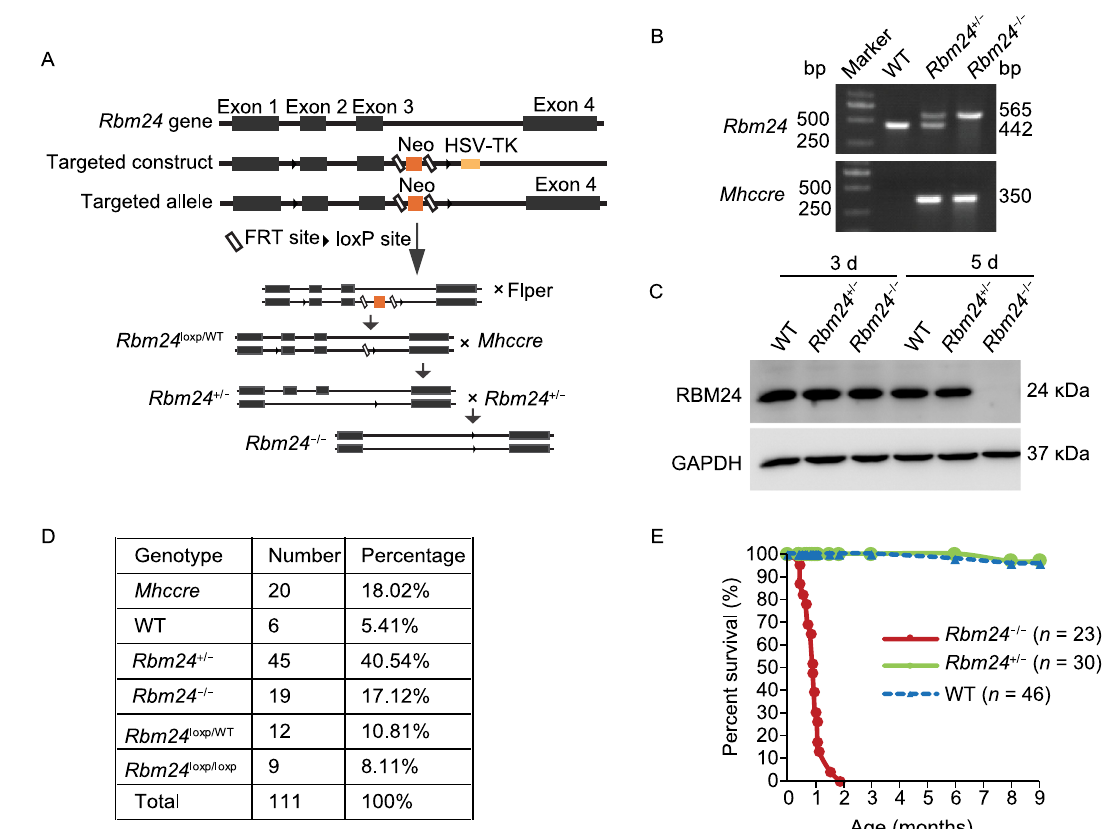
Figure 1. Generation of cardiac-speci fi c RBM24 knockout mice. (A) Cre-loxP system was used to disrupt the RBM24 tissue- speci fi cally in the heart. Schematic diagram represents WTand mutant loci of Rbm24 gene together with the targeting vector. Exons for the gene encoding Rbm24 were represented by a black box. We generated conditional RBM24 knockout mice by cross-breeding Rbm24 loxp/WT mice with Mhc cre knockin mice. (B) PCR genotyping analysis of RBM24 knockout mice. Rbm24 − / − produced the expected 565 bp mutant fragment compared with a 442 bp wild-type fragment. Data in each group are representative of 20 – 46 mice. (C) Western blot analysis of RBM24 protein from WT, Rbm24 − / − or Rbm24 +/ − mice at postnatal day 3 and day 5. GAPDH served as a loading control. Data in each group are representative of 5 – 10 mice. (D) Viable mice were born at approximately Mendelian ratios. (E) Cumulative survival curve of Rbm24 − / − , Rbm24 +/ − and WT mice. See also